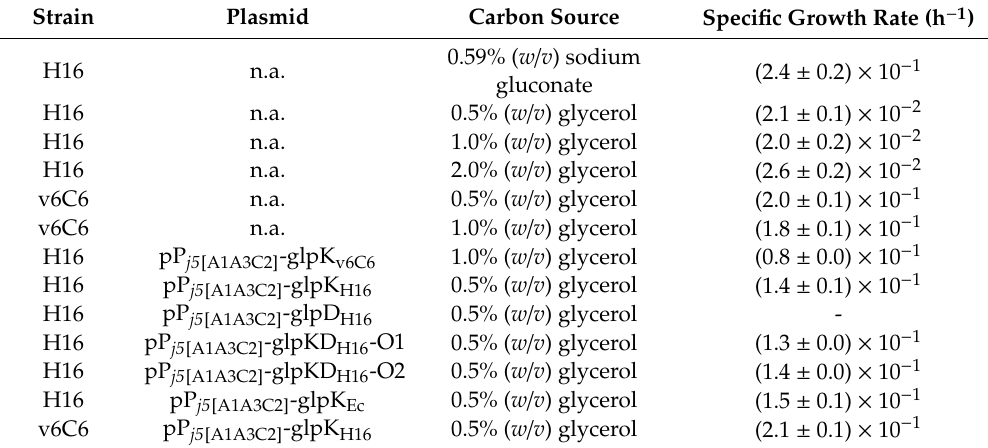
Figure 1. Growth curves of C. necator H16 wild-type in gluconate and laboratory-grade glycerol; 0.59% ( w / v ) sodium gluconate (blue line; circle), 0.50% ( w / v ) glycerol (red line; square), 1.00% ( w / v ) glycerol (green line; triangle), and 2.00% ( w / v ) glycerol (purple line; inverted triangle). The inset shows the magnified growth curve of C. necator H16 wild-type in 0.59% ( w/v ) sodium gluconate (blue line; circle) and 0.50% ( w/v ) glycerol (red line; square), with the dotted lines indicating OD 600 of 1.0 and 5.0. Table 1. Specific growth rate of C. necator H16 and v6C6 variant in sodium gluconate and laboratory-grade glycerol.